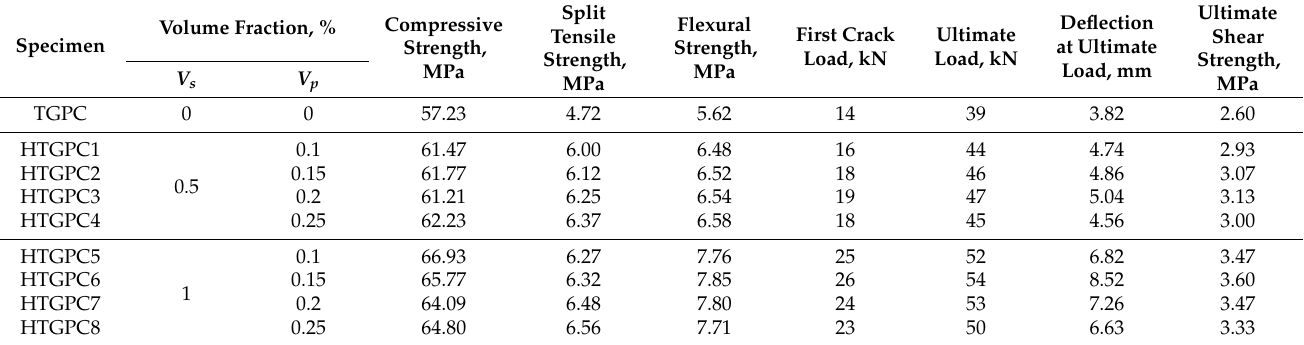
Table 3. Test Table 3. Test results.